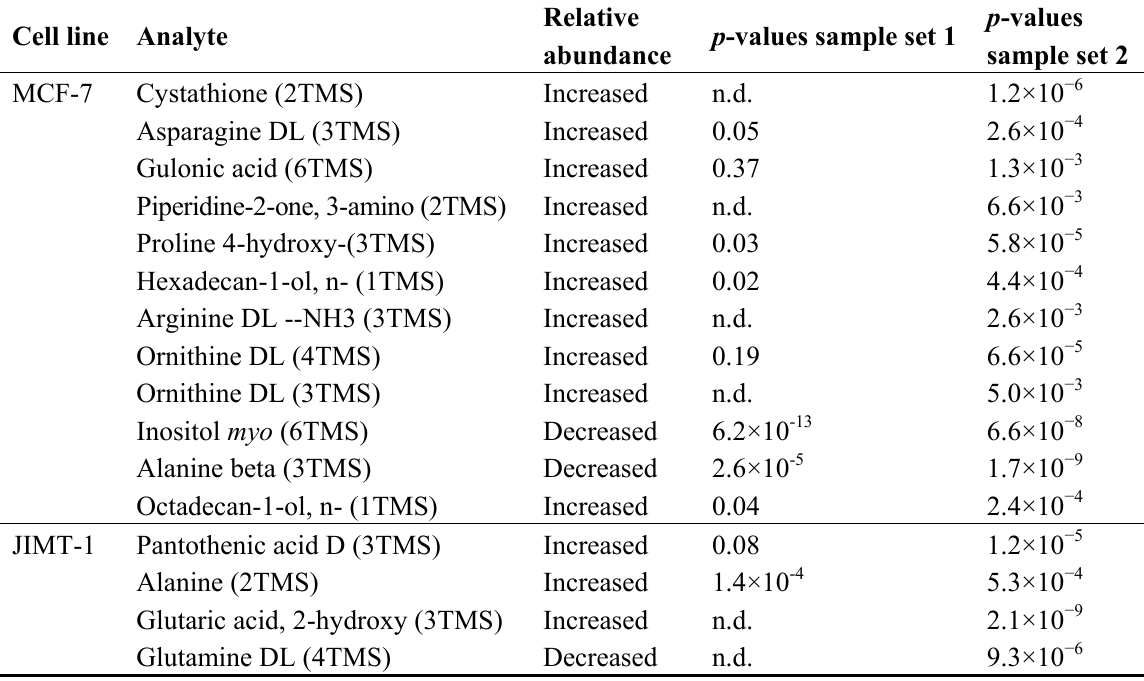
Table 2. Analytes with significantly different concentration in one cell line compared to all other cell lines. Metabolites of sample set 2 had to be significantly different after 24 h and after 48 h with mean ratios above 2 at both time points. Significance was assessed with Student’s t-test. p Values of the sample set 2 were calculated for each cell line against all others of the 48 h-value (n = 6; n.d. = not